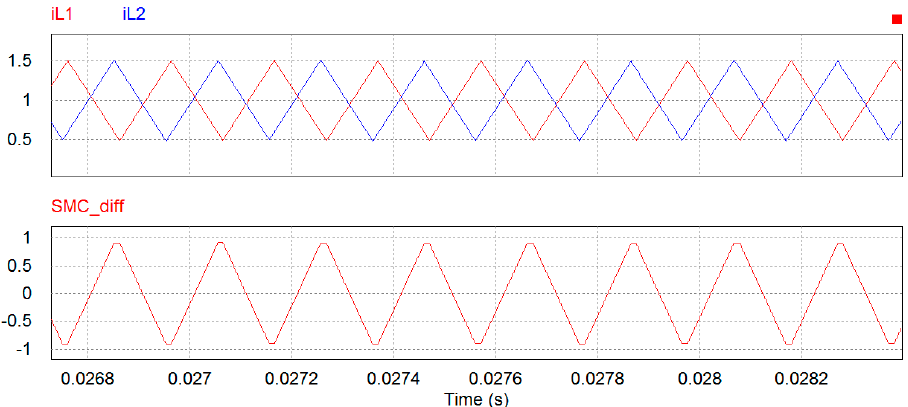
Figure 13. Forty-five percent of the phase error. Two inductor currents (upper) and s 2 * sliding surface